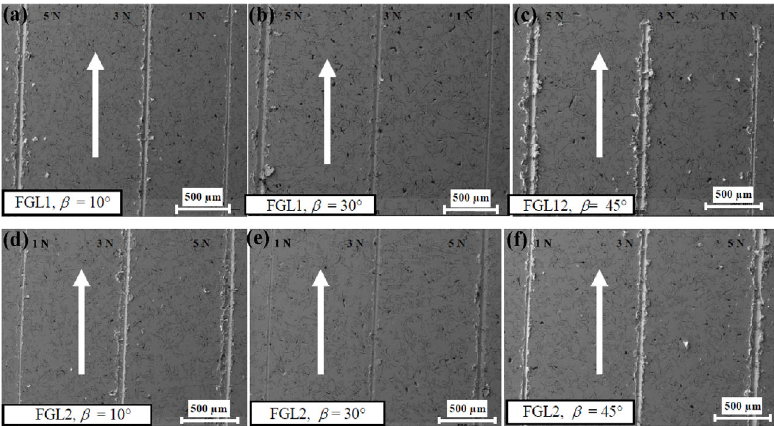
Fig. 6 SEM images of scratch damage on studied irons vs. normal load, F n (1, 3, and 5 N) and indenter attack angle,  (the arrows show the scratching